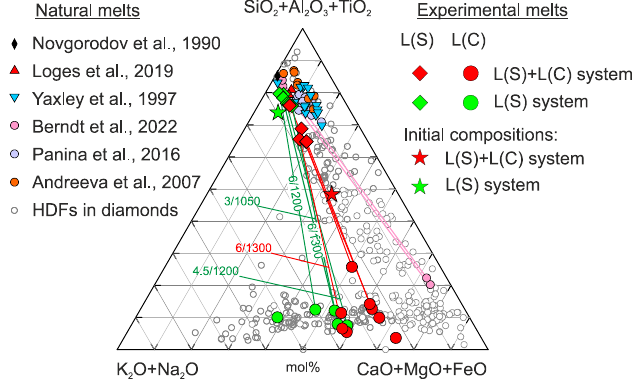
Figure 20. Pseudo-ternary projection of conjugate carbonatite and phonolite melts obtained in our experiments was compared with inclusions of melt or high-density fluids (HDFs) in diamonds, phonolite glasses in diamonds from Mir pipes [54] , silicate glasses in spinel peridotite xenoliths from Spitzberg, Germany [57] and Victoria, Australia [58] , as well as alkaline carbonatite-bearing complexes from Eifel, Germany [59] , Tomtor, Russia [60] , and Mushugai-Khuduk, Mongolia [61] . The compositions of melt/fluid diamond inclusions and corresponding references are summarized in Tables S8–S10 from [16] .